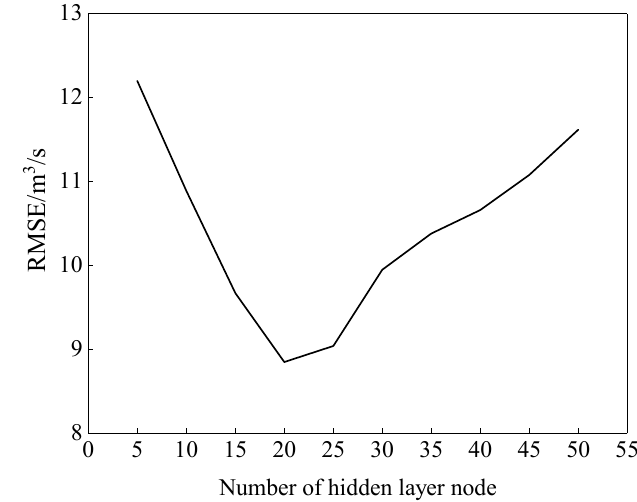
Figure 13. Relationship between RMSE (Root Mean Squared Error) and several hidden layer nodes.